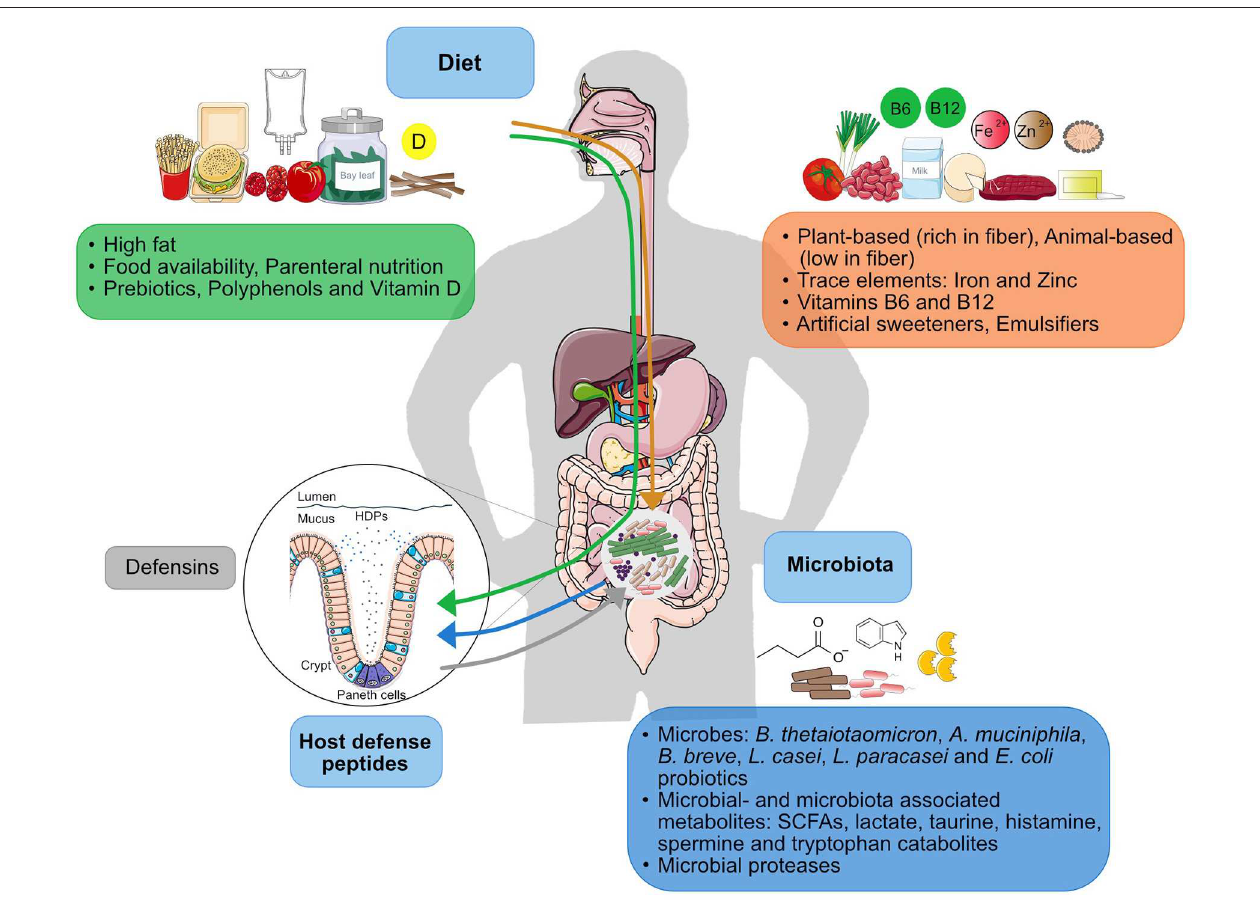
FIGURE 4 | Factors within the diet-microbiota-HDP axis. The continuous interplay between microbiota and HDP (blue and gray arrows) is constantly influenced by diet. Effect of dietary factors on the microbiota is represented by the orange arrow and the effect of dietary factors on HDP function is represented by the green